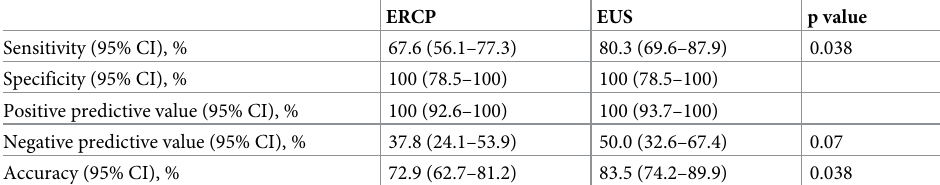
Table 3. Diagnostic performance of EUS and ERCP-based tissue sampling (n = 85).